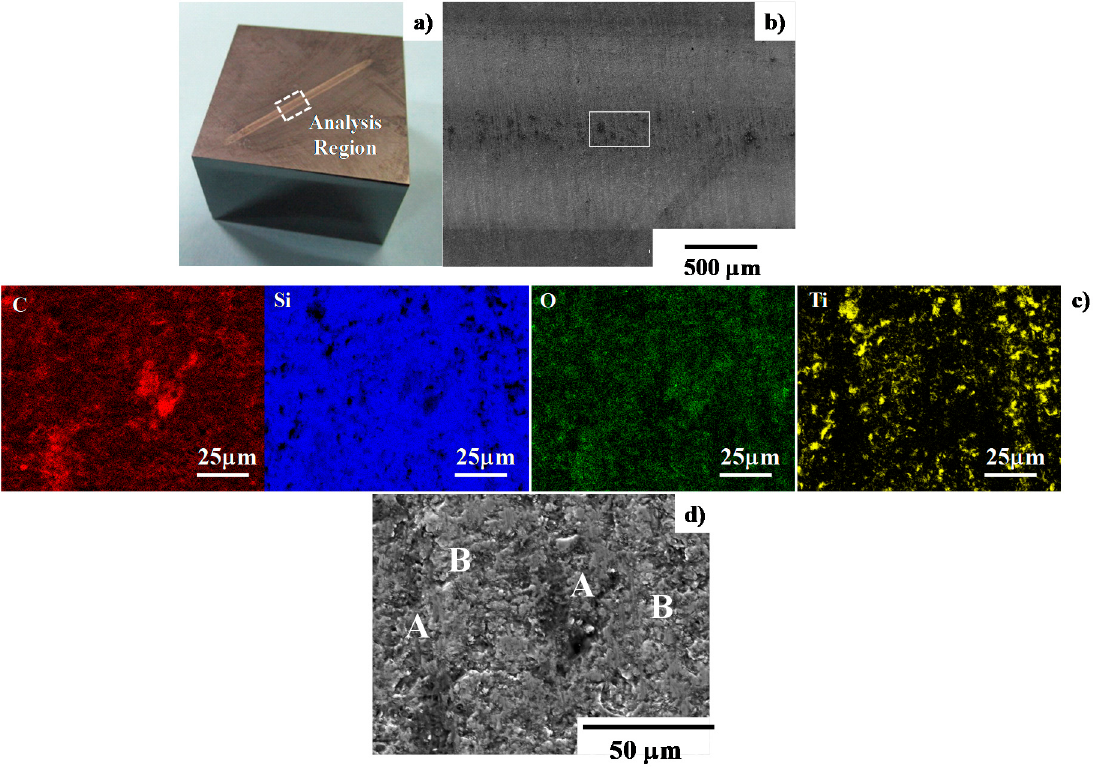
Figure 12. SEM and EDX analyses at the vicinity of the center of the contact interface between the SiC-coated punch and the titanium wire after forging by 10 shots up to the reduction of the diameter by 35%. ( a ) Optical microscopic image on the SiC coating punch surface; ( b ) SEM image in low magnification on the contact interface of the SiC coating; ( c ) element mapping by C, Si, O and Ti and ( d ) SEM image in high magnification at the center of the contact interface, where “A” indicates the high carbon concentration and “B” represents the titanium oxide deposits.